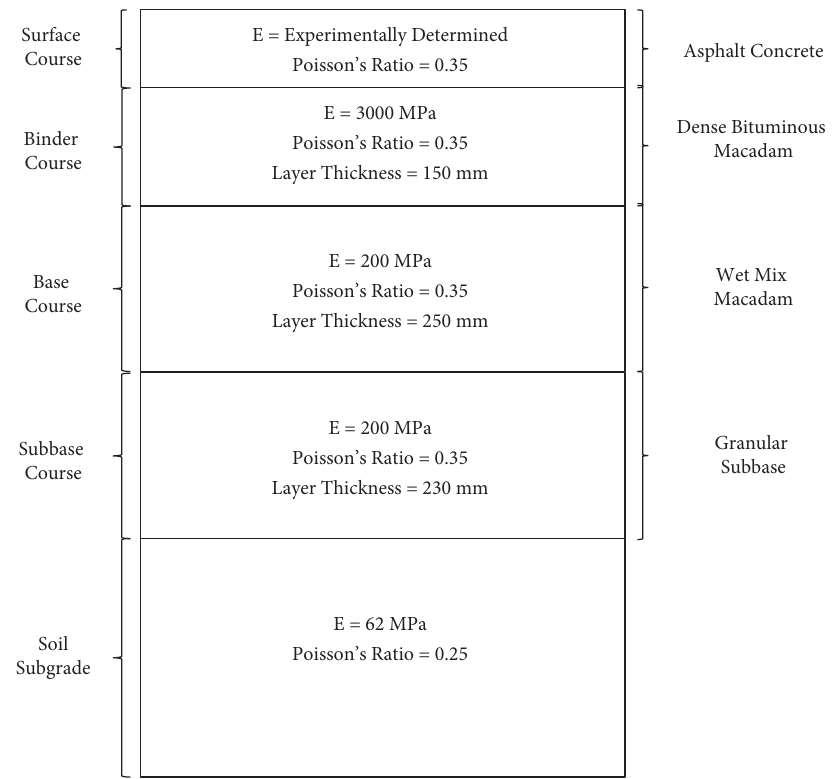
Figure 2: Pavement structure designed in this